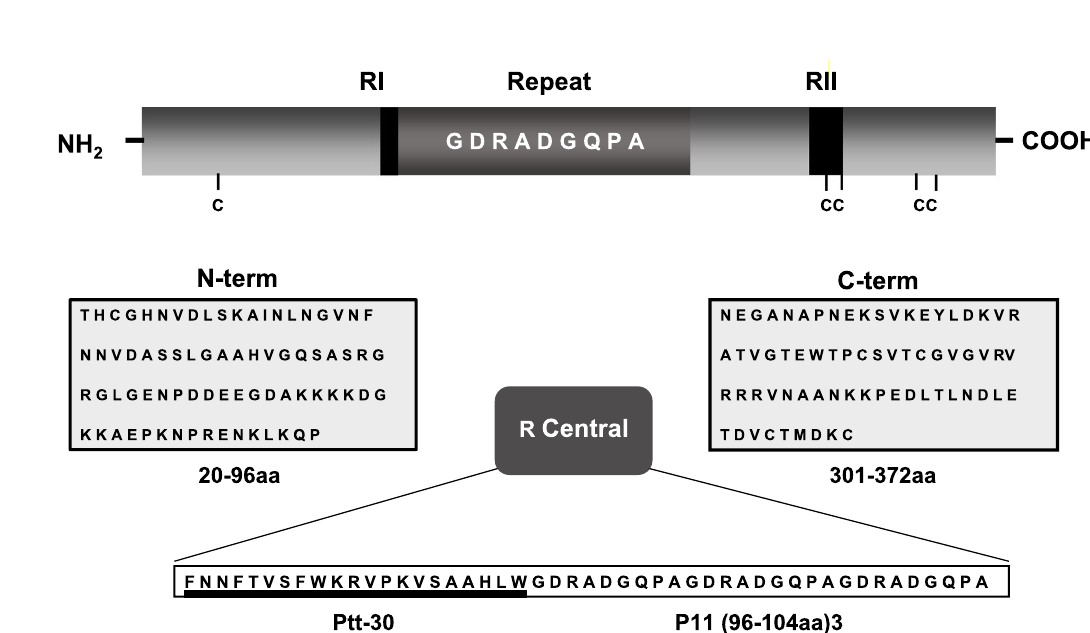
Fig. 2 Amino-acid sequences of the N, R, and C fragments. Sequence and localization of the three P. vivax CS LSP (N, R, and C) fragments used as immunogens. The N polypeptide corresponded to N-terminal amino acids (aa) 20 – 96 (N-term), and the C peptide to C-terminal aa 301 – 372 (C-term). The R peptide VK210 (type I) corresponded to a construct based on the fi rst central repeat (aa 96 – 104) in tandem three times and collinearly linked to a universal T-cell epitope (ptt-30) derived from tetanus toxin. For the fi rst dose a peptide mixture of N-terminal (term) and fragments (1N:1C) (50 μ g/each peptide) was used, whereas for the second and third doses the peptide mixture included N-term, C-term, and R fragments (1N:1C:1R) (50 μ g/each